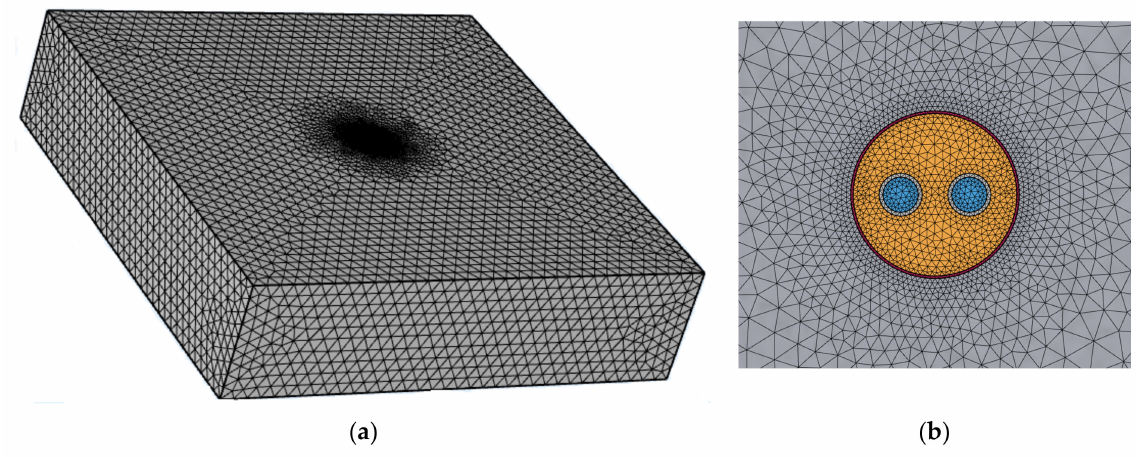
Figure 16. Computational domain with Mesh 2 ( a ) and particular of the upper surface ( b ).